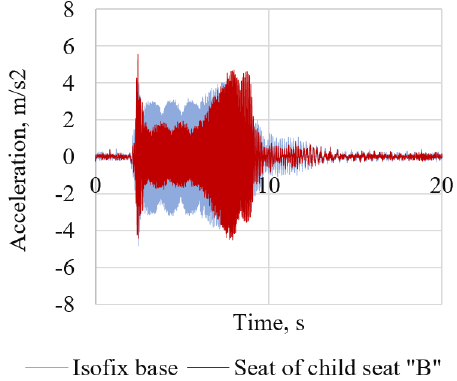
Figure 4: Vertical accelerations recorded on the seat B and ISOfix base (suspension in a dynamic position, the seat is loaded with a mass of 5 kg)